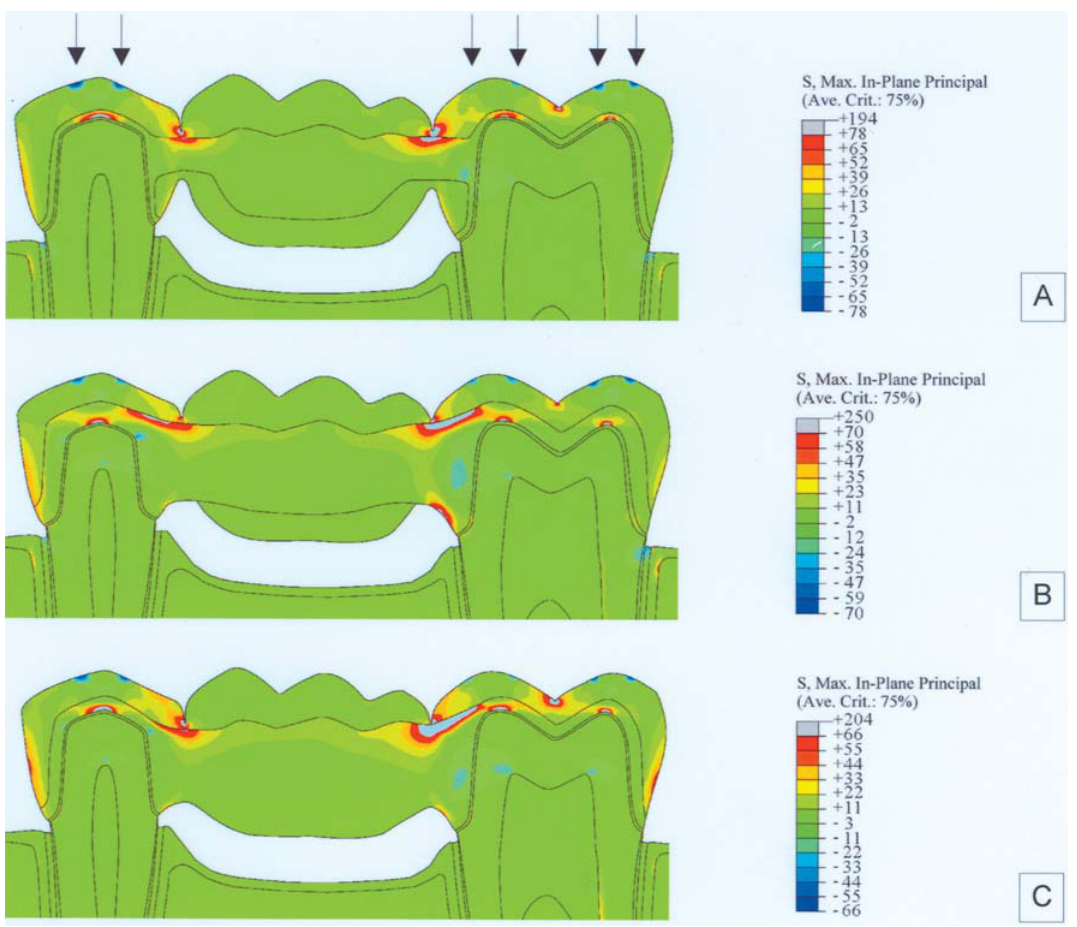
FIGURE 3- Stress distribution found when the load was applied only on the abutment teeth. Models: (A) Metal-ceramic FPD; (B) All-ceramic-OC FPD; (C) All-ceramic-O